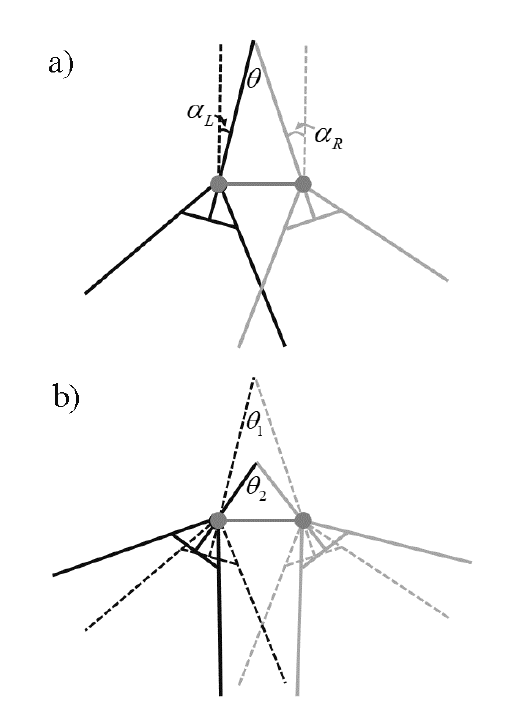
Figure 7: Field of view angle of a stereo vision sensor in rela- tion to the tilt angles (a) and broadening by them (b). monocular imaging setting. This will limit the mutual ground coverage of